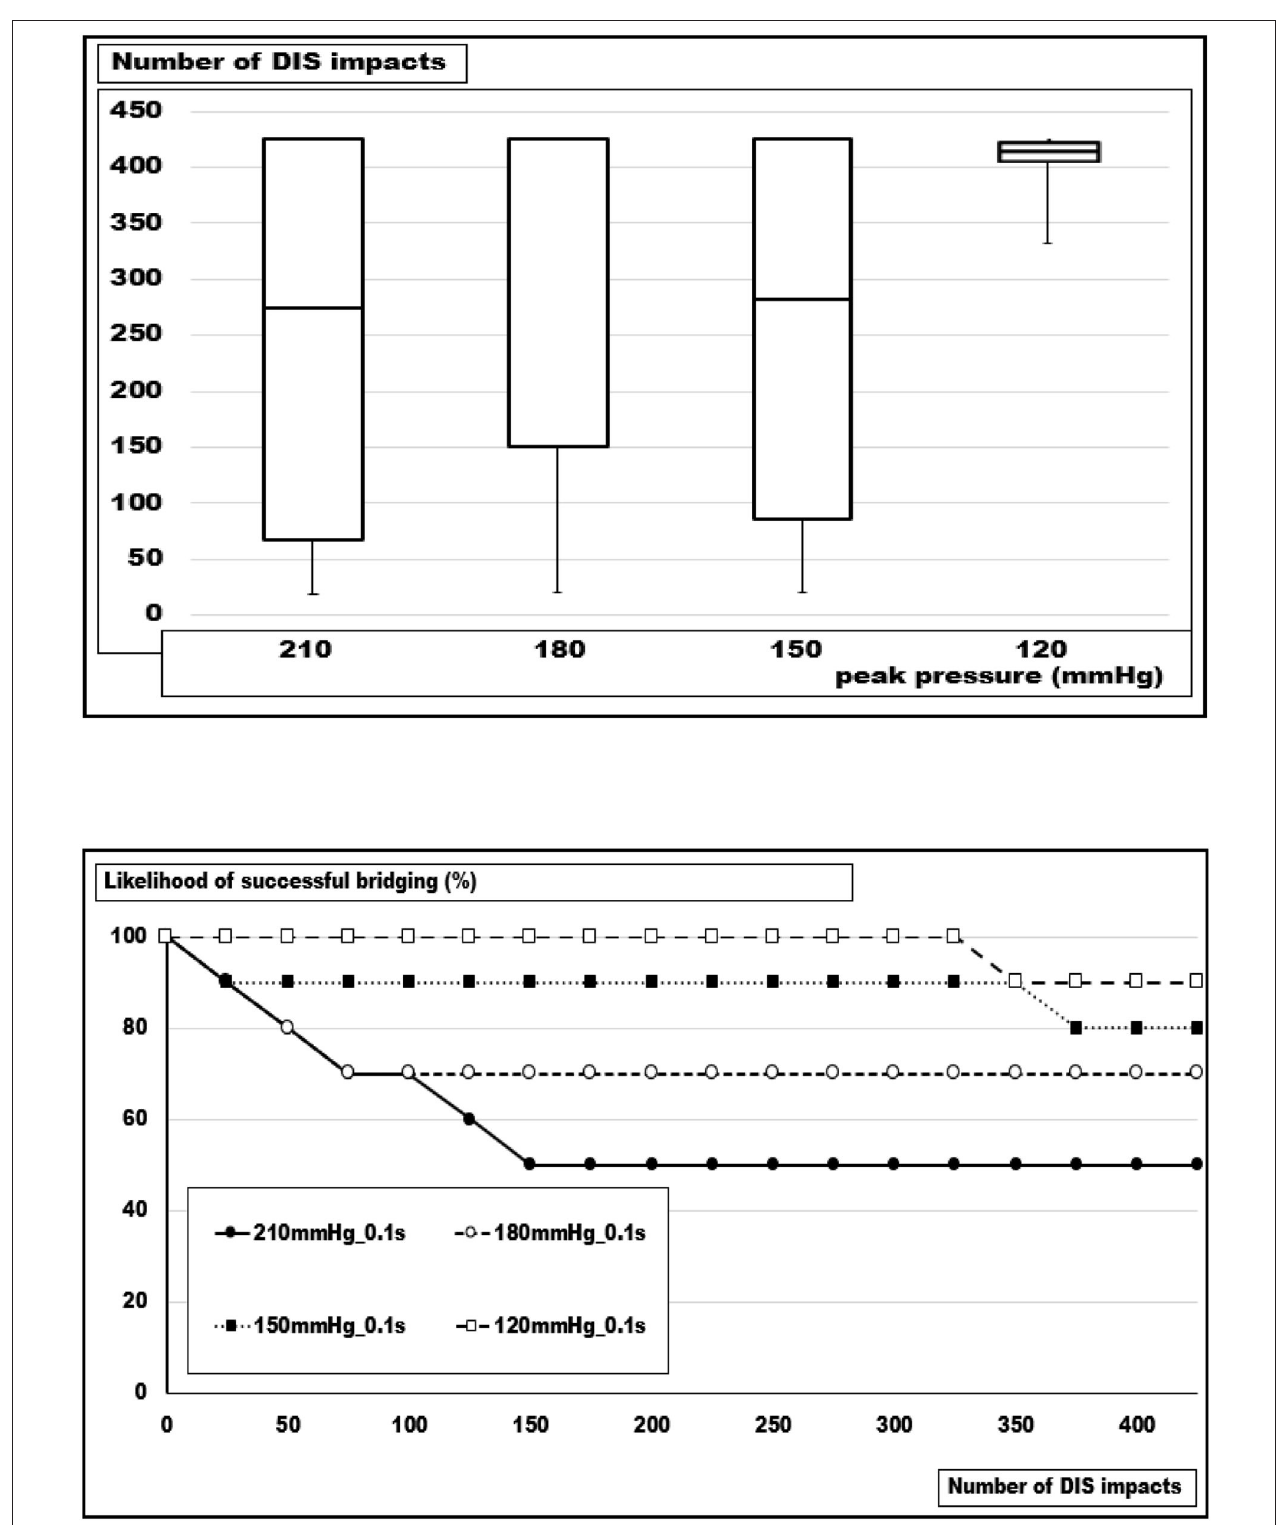
FIGURE 6 | (Top) Box- and whisker-plots and (bottom) likelihood curves of the number of DIS impacts withstood at pressure peaks of 210, 180, 150, and 120 mmHg. As a trend, an increasing load destabilizes the reconstruction of a 5cm orifice bridged with square Dynamesh Cicat® hernia meshes without fixation (Kruskal-Wallis: p = 0.05705; u -test 240 vs. 120 mmHg: p = 0.01552).